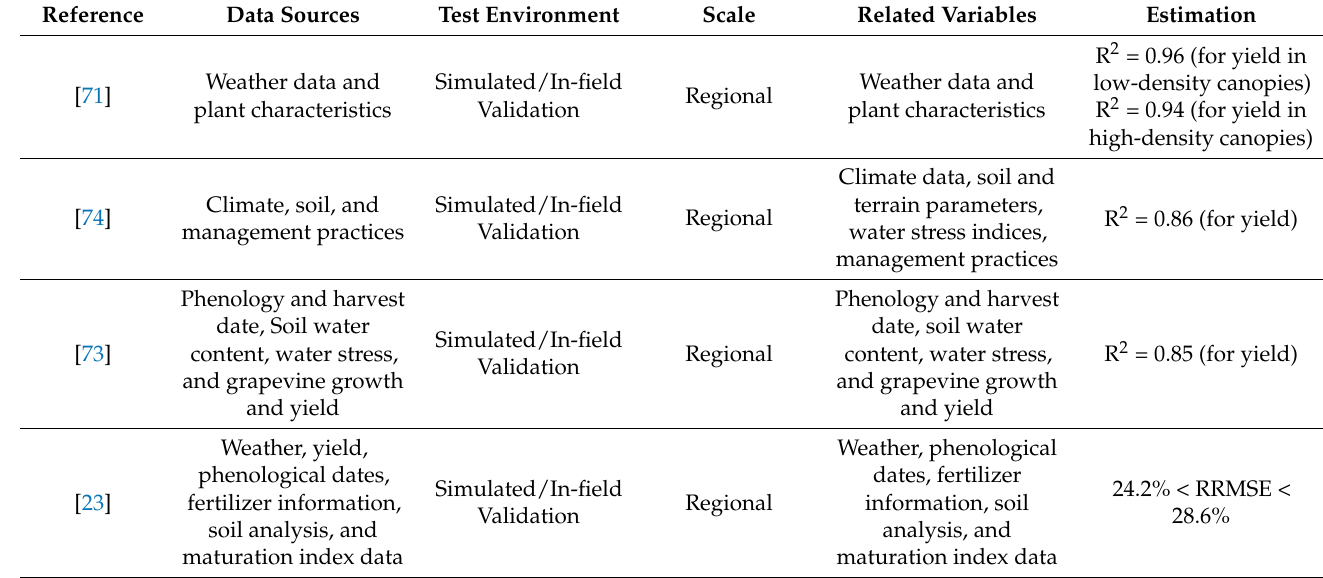
Table 5. Summary of records included in the systematic review (D—crop simulation